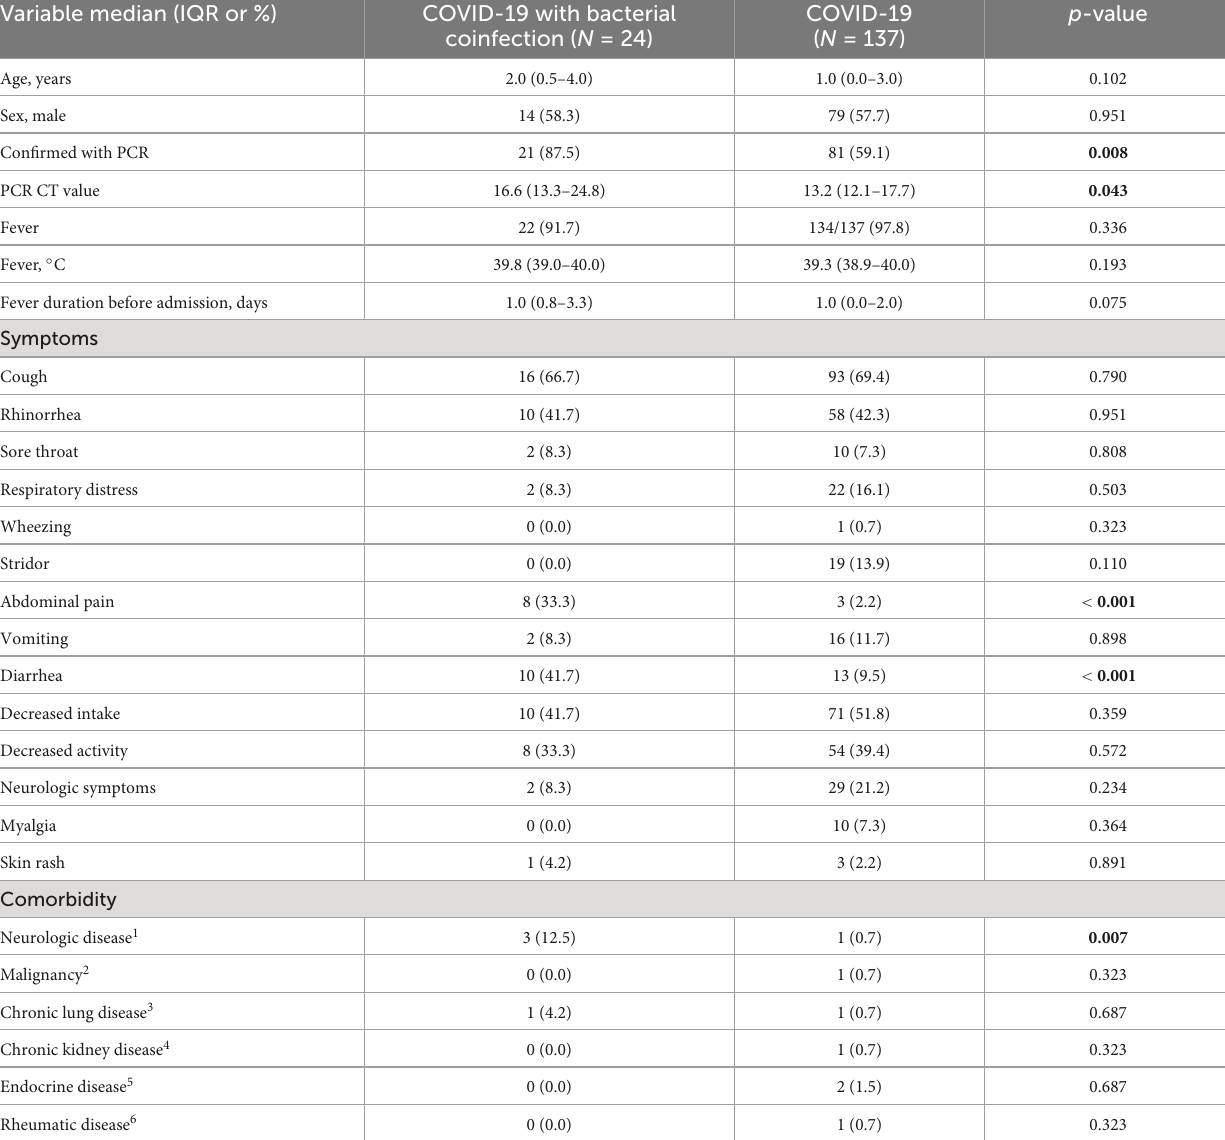
TABLE 1 Comparison of demographic profiles, clinical features, and comorbidities of both groups. Variable median (IQR or %) COVID-19 with bacterial